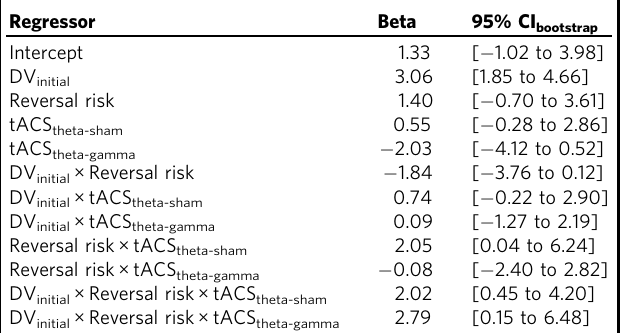
Table 2 Results of MGLM explaining choices (1 = precommit, 0 = postpone decision) in the precommitment task.